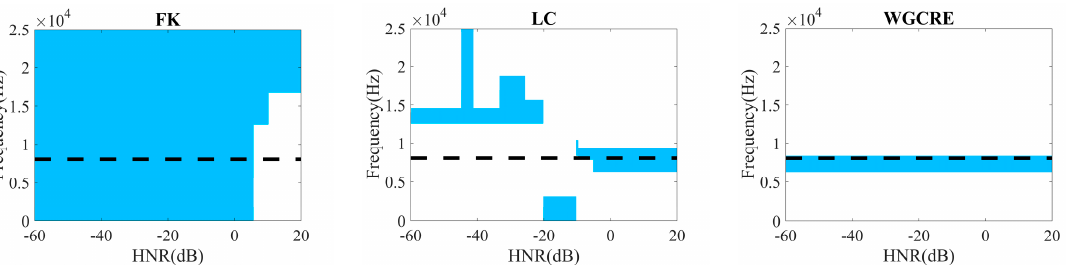
Figure 7. Selected optimal demodulation bands under single-sample dropout for different HNR.